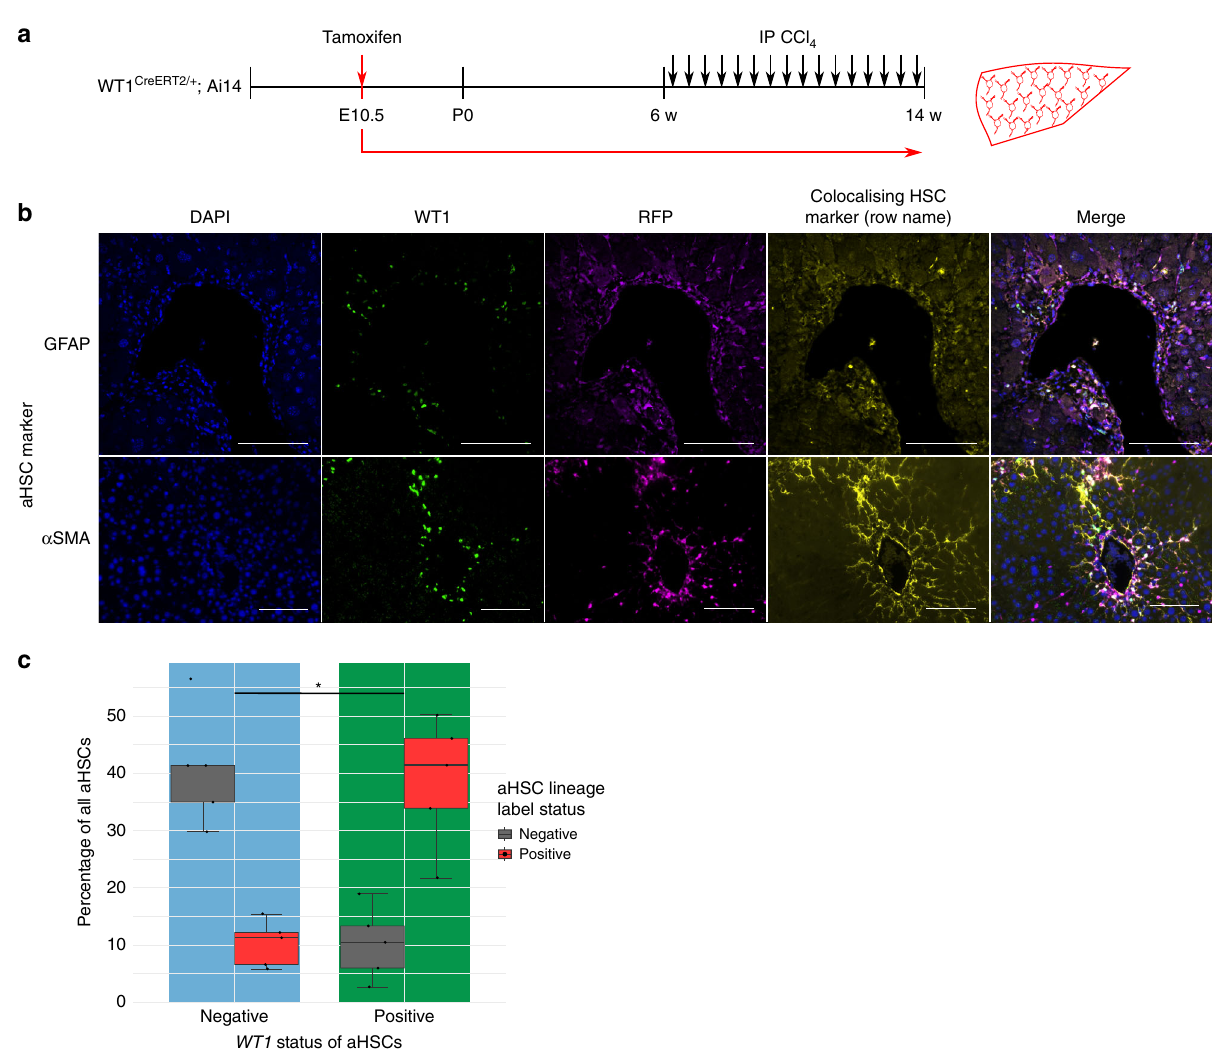
Fig. 2 Adult injury induces a population of WT1-positive cells by activation of qHSCs that derive from the embryonic hepatic mesothelium. a Lineage labelling of hepatic mesothelium-derived cells was induced at E10.5 in a further cohort of WT1 CreERT2/ + ;Ai14 animals and fi brosis induced by iterative injury with CCl 4 . b Lineage-labelled cells after injury were con fi rmed to be aHSCs by confocal microscopy demonstrating colocalization of the lineage label (RFP — lilac) with the HSC marker GFAP (yellow). Activated lineage-labelled cells were quanti fi ed after staining of injured livers for WT1 (green), lineage label (RFP — lilac), and α SMA (yellow) to demonstrate a population of WT1-positive activated cells originating from mesothelial-derived qHSCs. c 78.1 ± 5.3% of WT1-positive cells were lineage labelled, compared with 20.5 ± 3.7% of WT1-negative cells (Welch two-sample t -test t (7.144) = − 7.9601, * p = 8.437 × 10 – 5 , n = 5 animals, data are represented as individual points with median (centre line), fi rst and third quartiles (lower and upper box limits), 1.5× interquartile range (whiskers). Scale bars 100 μ